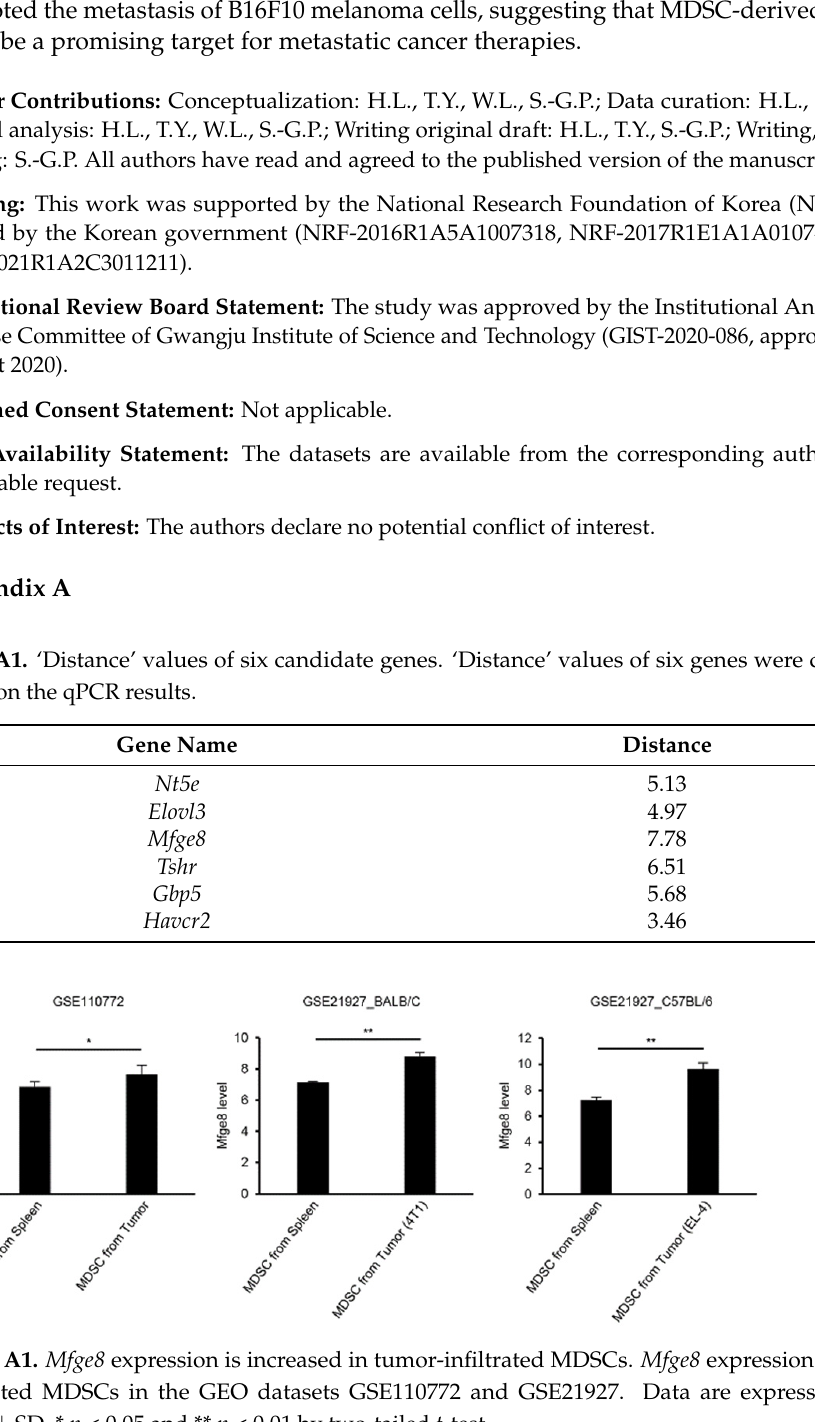
Figure A2. S-Mfge8 expression level is higher than L-Mfge8 in B16F10 cells. Analysis of L-MFGE8 and S-MFGE8 mRNA levels in B16F10 cells by qPCR. Data are expressed as the mean ± SD. * p < 0.05 by two-tailed t -test. References 1.